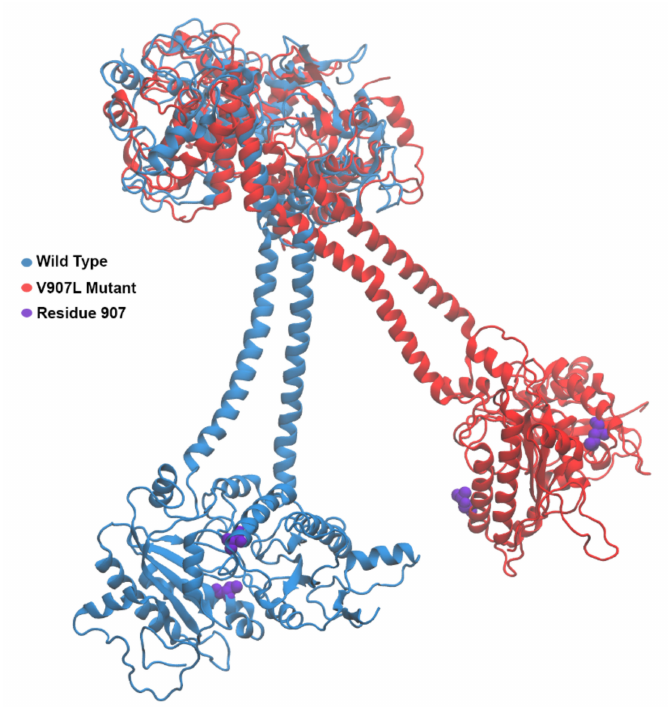
Figure 6. Bovine GC-E protein structure. Starting from the top, the kinase homology domain is shown, which is followed by the alpha-helical dimerization domain, and concludes in the catalytic domain. The wild-type structure is shown in blue, and the V907L mutant is shown in red. Occurrences of residue 907 are shown in